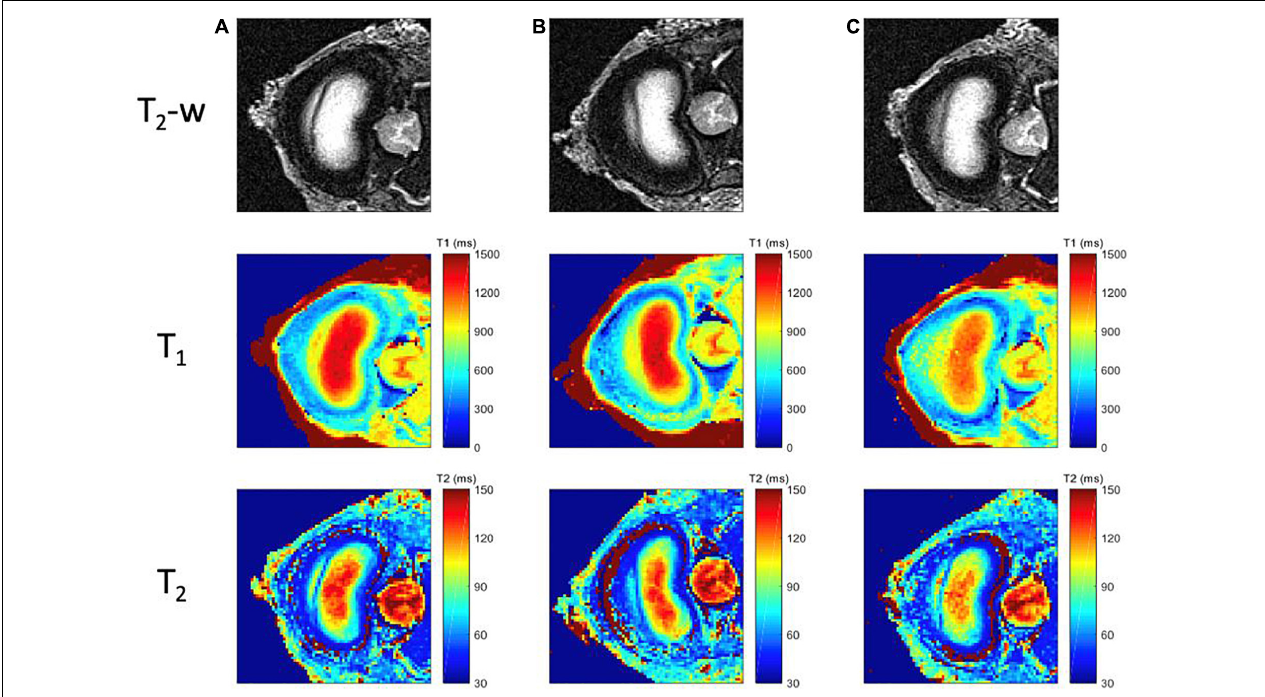
FIGURE 5 | MR images for each mechanical loading state of the intact specimen. First row corresponds to the T 2 -weighted images; second row to the computed T 1 maps, with a scale ranging from 0 ms (blue) to 1500 ms (red); and third row to the T 2 maps, with a scale ranging from 20 ms (blue) to 150 ms (red); for three different positions (A) Neutral (step 1) (B) Flexion (step 2), (C) Extension (step